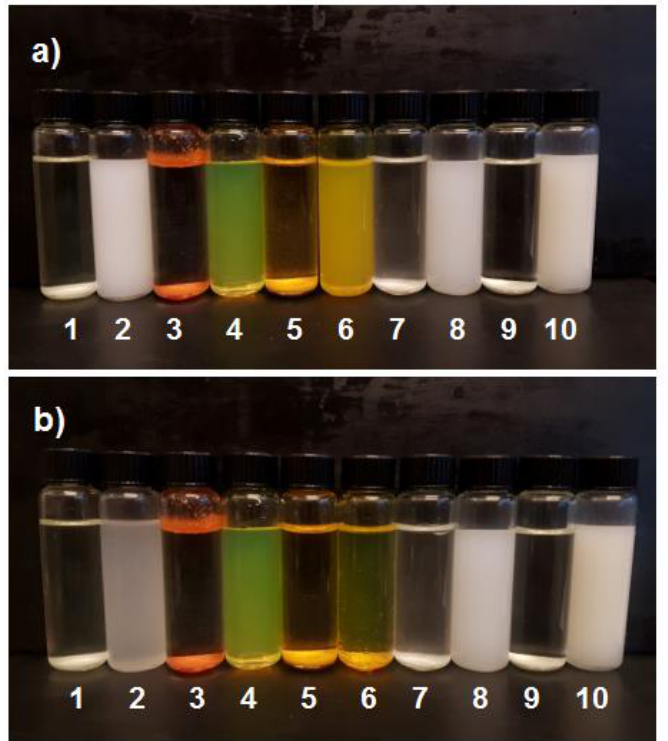
Figure 2. Visual inspection of the status of the dispersion for AMI (1 and 2), COU (3 and 4), CUR (5 and 6), NOR (7 and 8) and PRO (9 and 10) before (i.e., in the solvent solution) and after antisolvent precipitation, respectively, performed for ( a ) fresh samples and ( b ) after 7